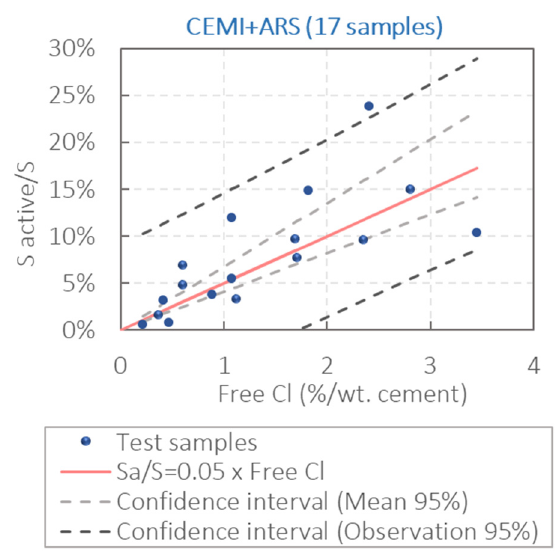
Figure 5. Evolution of the actual anodic surface on an apparent anode as a function of the content of free chlorides. From the measurement of the real corroded surface area of the apparent anode (Figure 5), we can calculate the corrosion current density i corr , by dividing I g per the anodic surface, as a function of the amount of free chlorides present near the reinforcement in the porosity of the concrete (Figure 7).